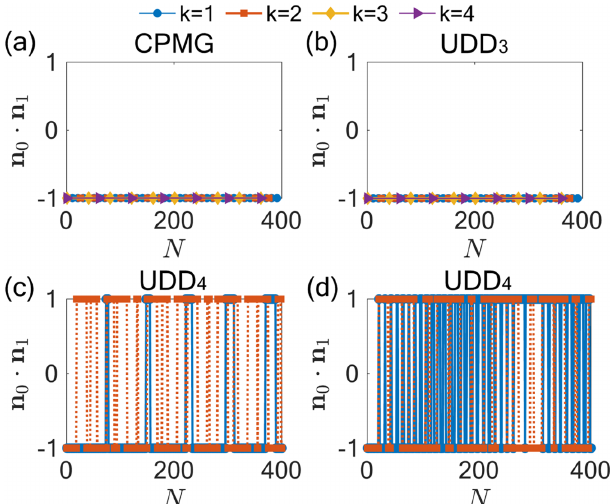
FIG. 1. Dot product of nuclear spin rotation axes for (a) CPMG, (b) UDD 3 , and (c),(d) UDD 4 versus the number of iterations N of the basic pulse sequence unit at the first four ( k ∈ ½ 1 ; 4 (cid:2) ) 2 π · ð 80 ; 25 ; 314 Þ kHz] resonances of a target spin [ ð A;B; ω L Þ¼ for an electronic spin with S ¼ 1 = 2 . For CPMG and UDD 3 , n 0 · n 1 is independent of N , since the rotation angles ϕ 0 and ϕ 1 per iteration are equal. For UDD 4 , the dot product jumps between − 1 and þ 1 due to the different rotation angles ϕ . In the ranges where j n 1 , it holds that ϕ ≈ ϕ n 0 · 1 ¼ 0 1 , and the rotation of the nuclear spin is unconditional on the electron. In (c) we consider the resonance time 4 π ð 2 k − 1 Þ = ˜ ω and in (d) the time 8 π ð 2 k − 1 Þ = ˜ ω . 3 . 1822 ; 9 . 5465 ; 15 . 9108 ; 22 . 2751 Þ μ s The times for (a) are t k ¼ ð 3 . 1850 ; 9 . 5537 ; 15 . 9124 ; 22 . 2805 Þ μ s, (c) t 3 . 1857 ; (b) t k ¼ ð k ¼ ð 9 . 5481 ; 15 . 9169 ; 22 . 2737 Þ μ s, and (d) t 6 . 3661 ; 19 . 0883 ; k ¼ ð 31 . 8190 ; 44 . 5509 Þ μ s. For the UDD sequences, we optimize the time around the